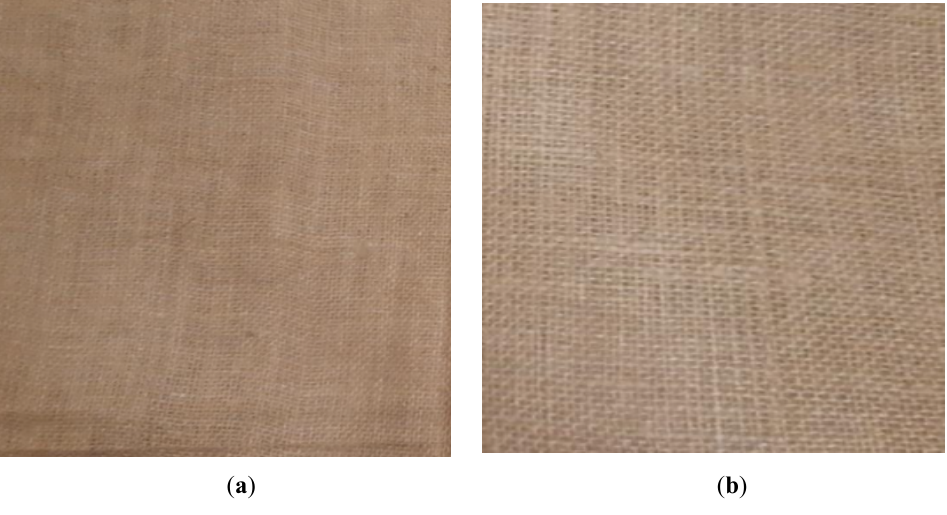
Figure 1. Image of ( a ) plain-woven ramie ( b ) plain-woven jute.